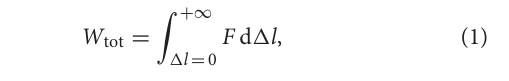
FIGURE 4 | Force vs. displacement plot for the experiment shown in Figure 3 (skin specimen V). Labels t 0 – t 6 refer to the times of the frames in this other figure. The relatively linear relation at small displacements allows to invert for the skin’s Young modulus E . The area below the plot is the total mechanical work W tot provided to the sample. The mean stress at the onset of rupture is called σ f